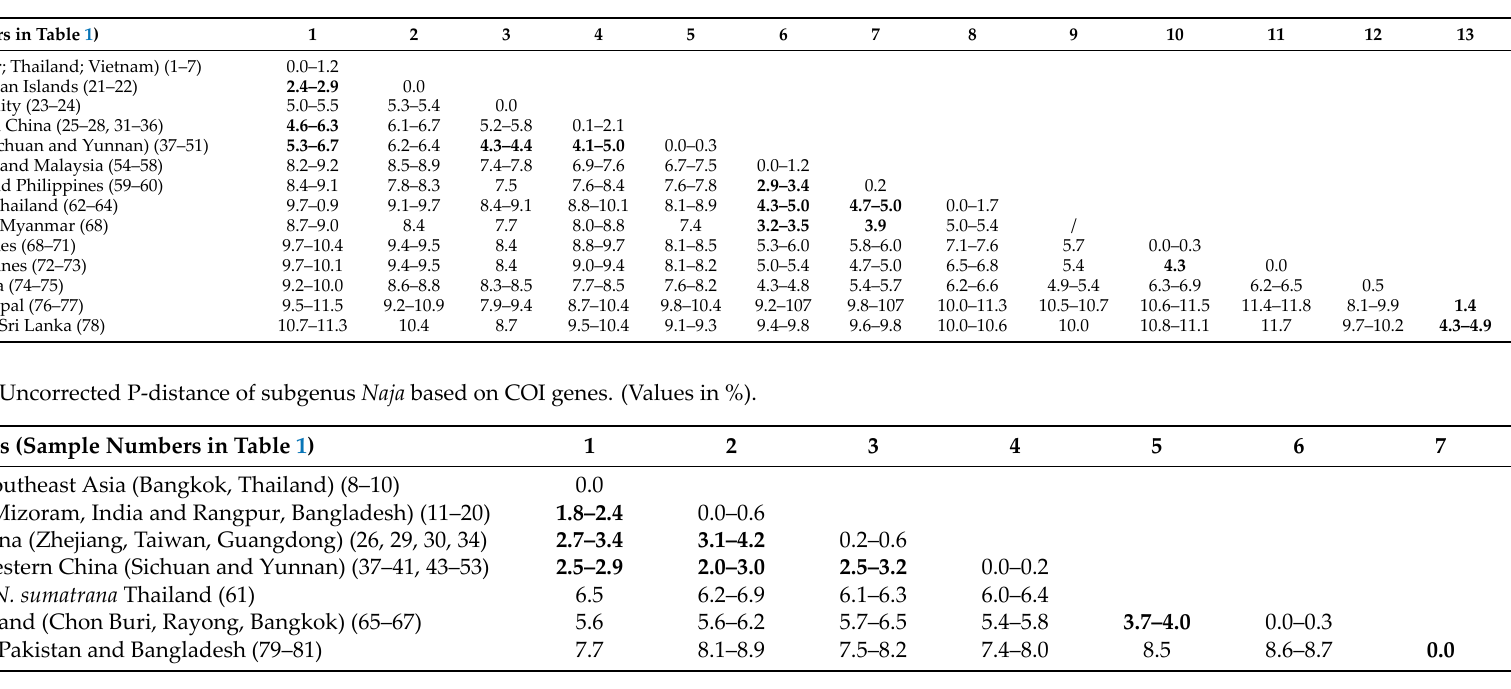
Table 2. Uncorrected p ‑distances based on cyt b genes for subgenus Naja. (Values in %).